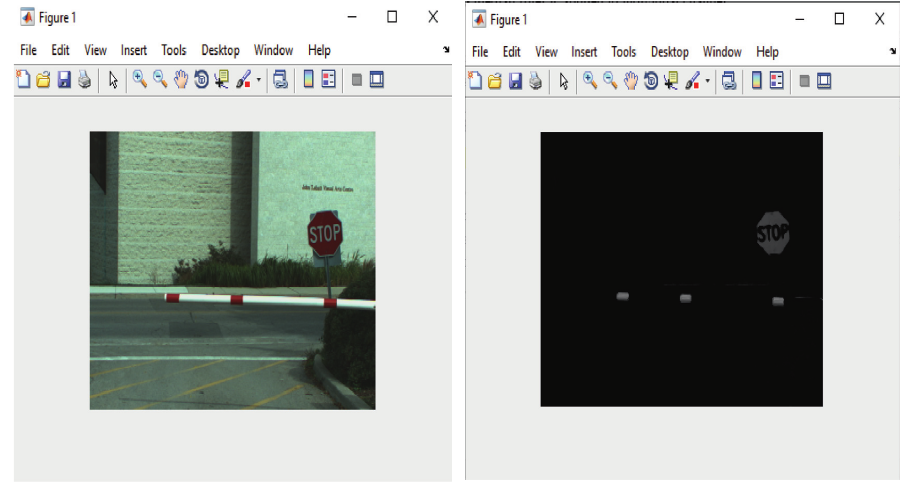
Figure 4: Examples of processing red